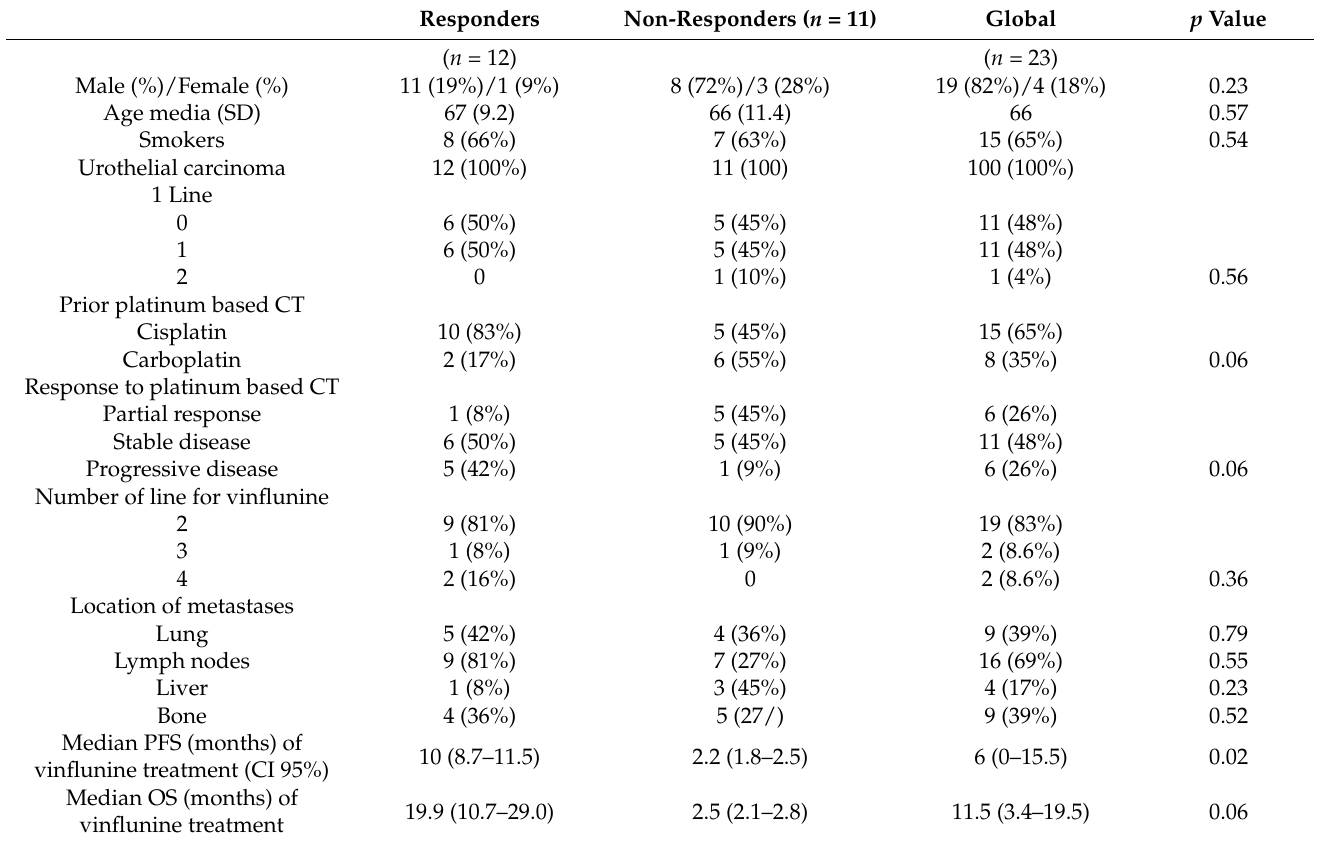
Table 1. Characteristics of patients ( n =